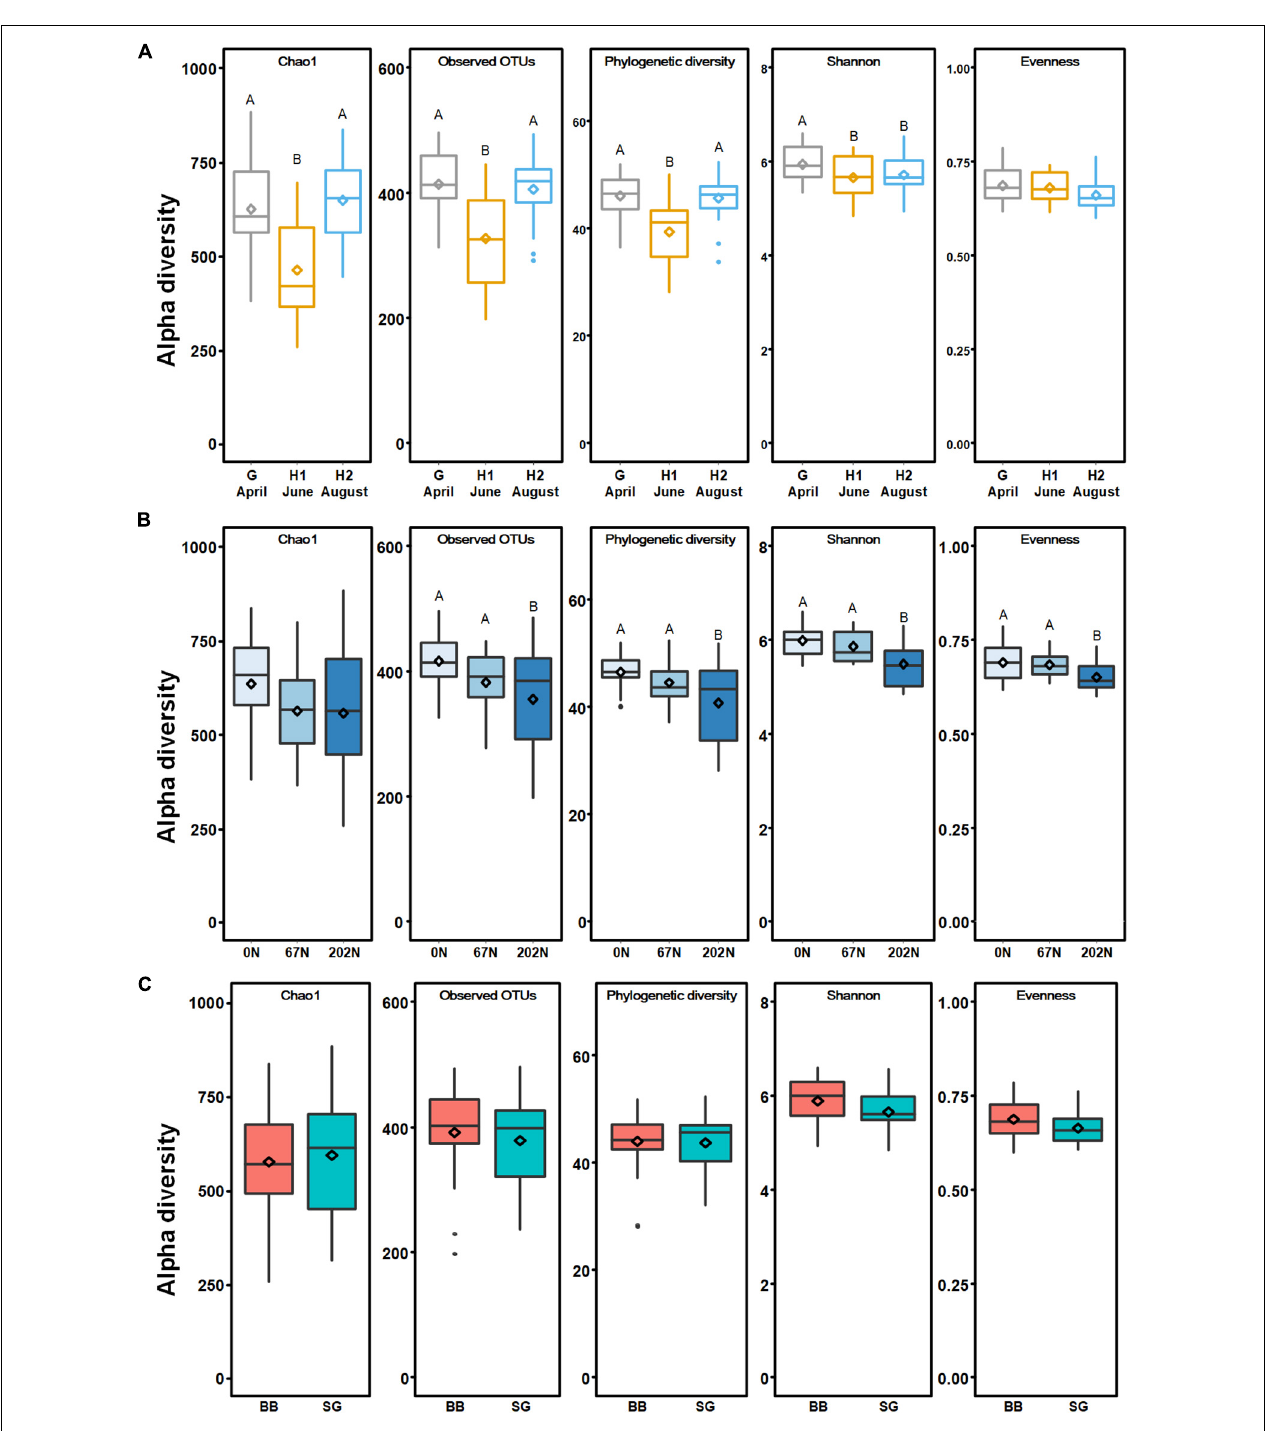
FIGURE 3 | Alpha-diversity of diazotrophic microbial communities in relation to agricultural seasons (A) , nitrogen fertilization rates (B) , and grass species (C) . Boxes represent the interquartile range (IQR). Lines within boxes represent median values. Whiskers represent the range between minimum and maximum values. Dots represent outliers outside of this range. Diamonds represent mean values. Different letters above boxes indicate significant differences between treatment levels within groups by comparing means using least significant difference (LSD) tests ( α = 0.05). The letters were only shown in groups that have significant effects. G, grass green up; H1, initial grass harvest; H2, second grass harvest; 0N, no N fertilization; 67N, 67 kg N ha − 1 fertilization; 202N, 202 kg N ha − 1 fertilization; BB, big bluestem; SG, switchgrass.